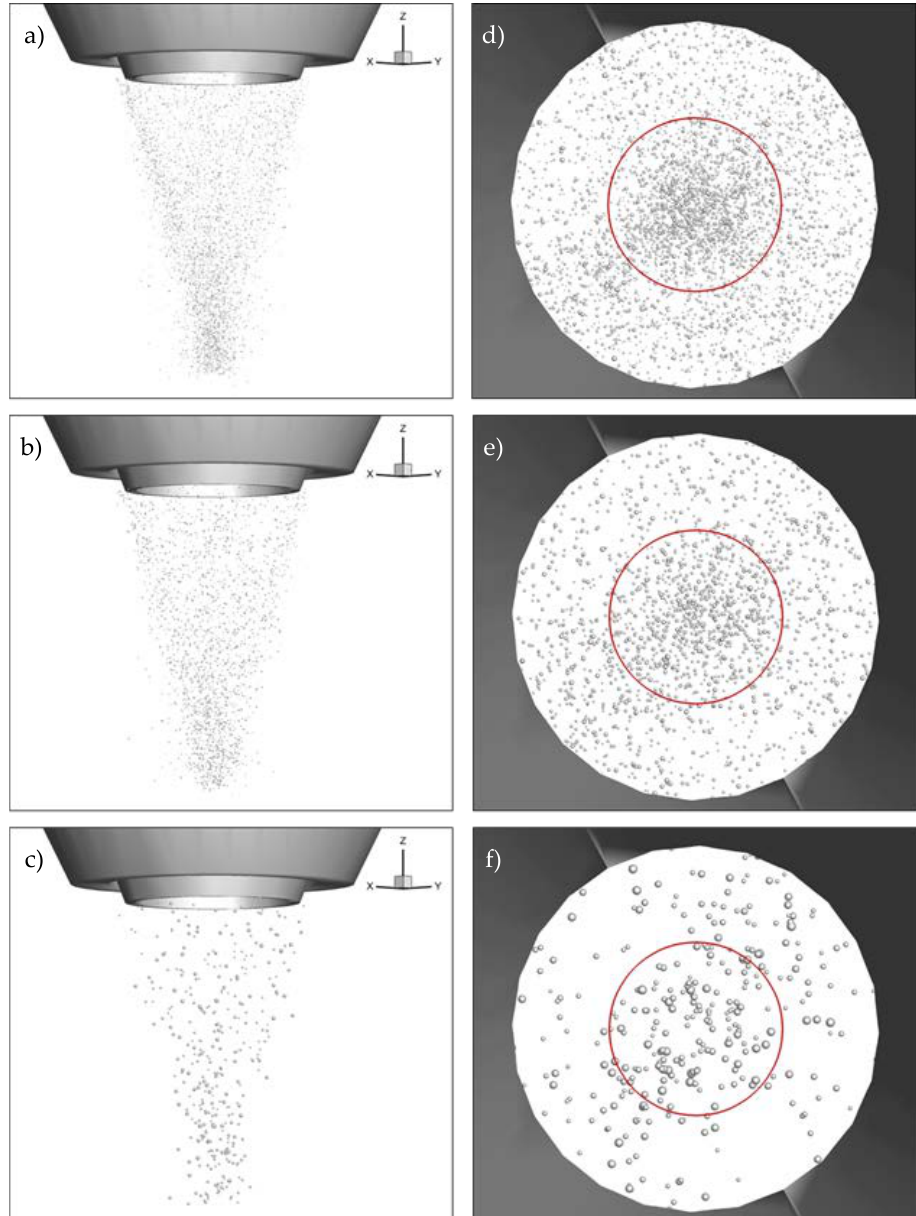
Figure 18. ( a ), ( b ), ( c ): Lateral views of the simulated powder-gas jet up to level E8. ( d ), ( e ), ( f ): Coaxial views of the powder-gas beam for level E8, red: laser beam. Grain fractions at the top: − 45 + 11 µm, center: − 53 + 20 µm, bottom: − 90 + 45 µm. Parameters: . m [1]. Reprinted with permission from Ref [1]. Copyright 2020, Fraunhofer